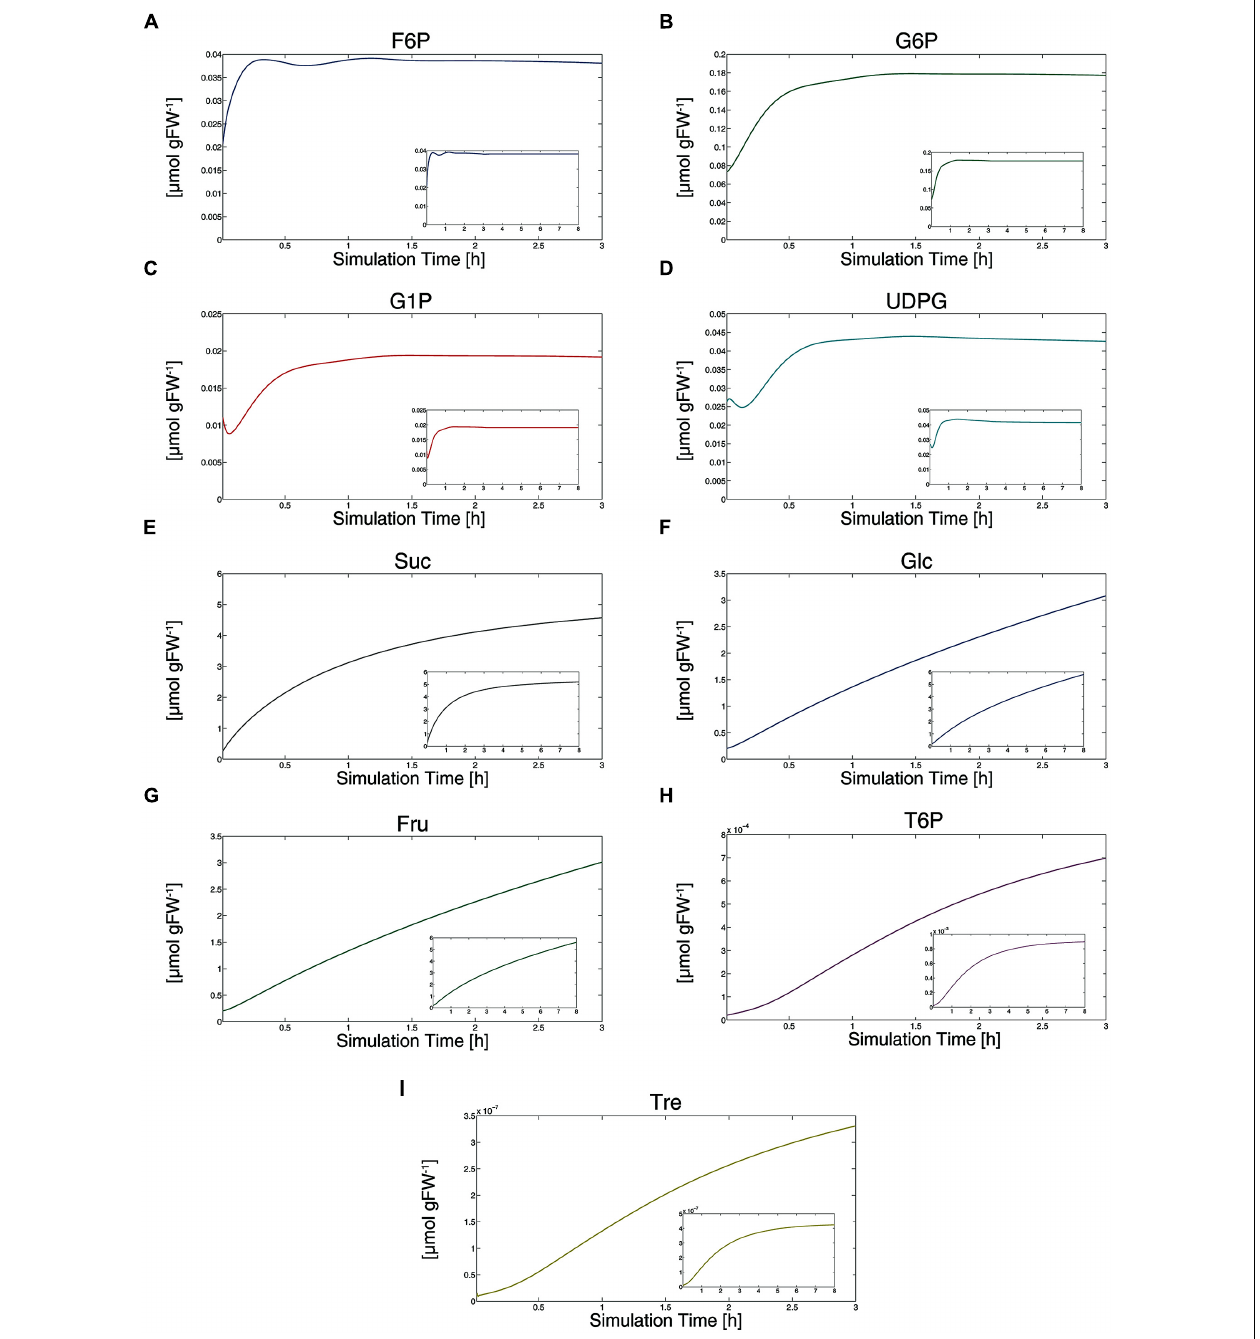
FIGURE 3 | Simulation of metabolite dynamics induced by external sucrose supply. Results of simulations are provided for all metabolites (A–I) within a simulation period of 3 h (large diagrams) and 8 h (small diagrams). Except forTre (I) , simulations of 3 h directly refer to experimental findings ofYadav etal. (2014).